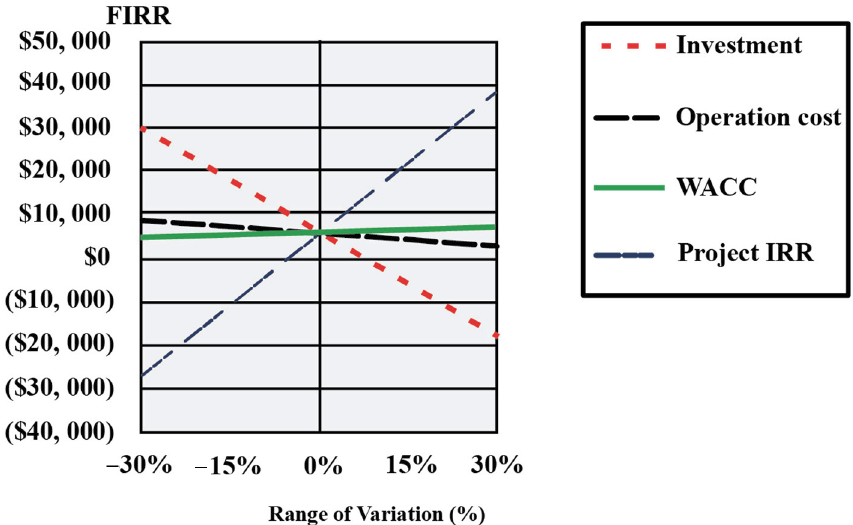
Figure 7. Schematic diagram for IRR sensitivity analysis